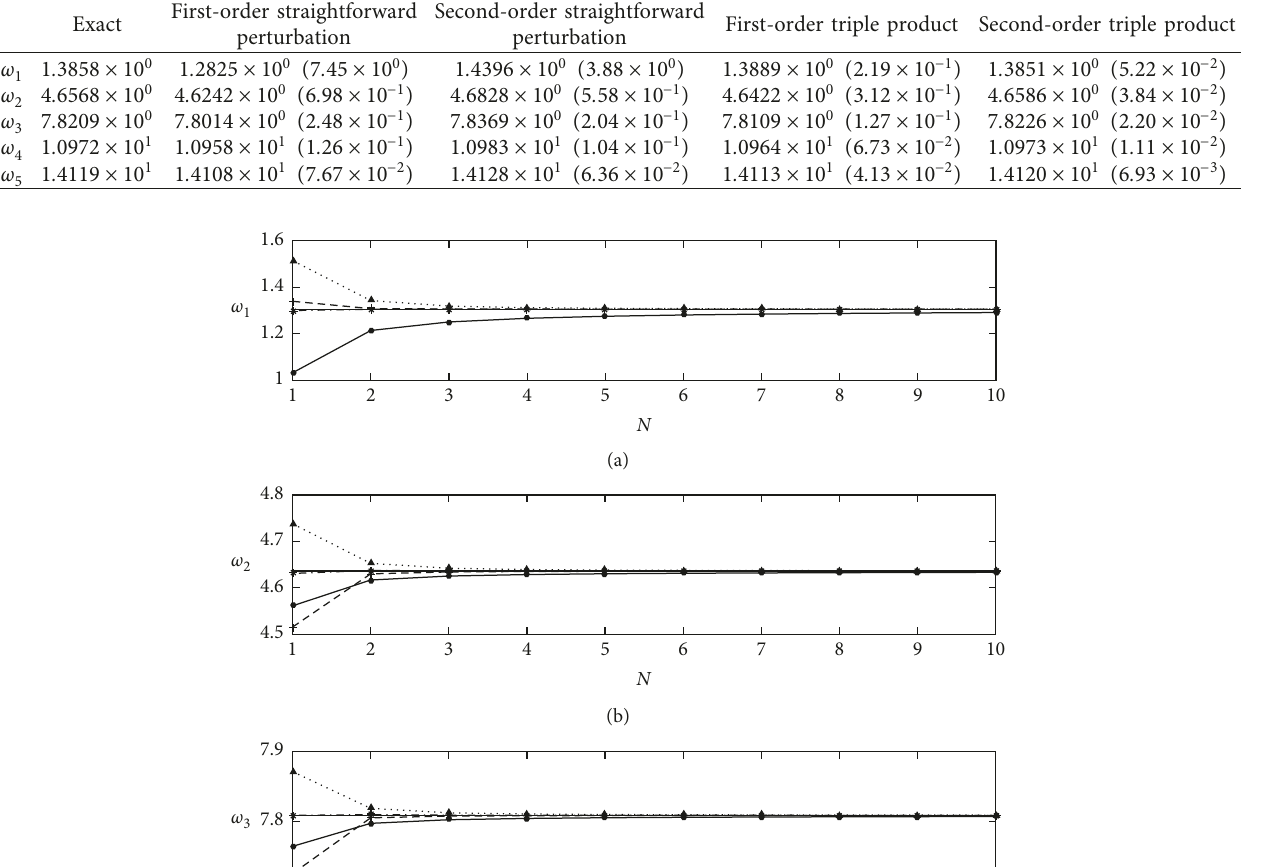
Table 11: The exact and approximate natural frequencies for the nonuniform rod of Figure 17 for a � 0 . 35. The natural frequencies are nondimensionalized by dividing by